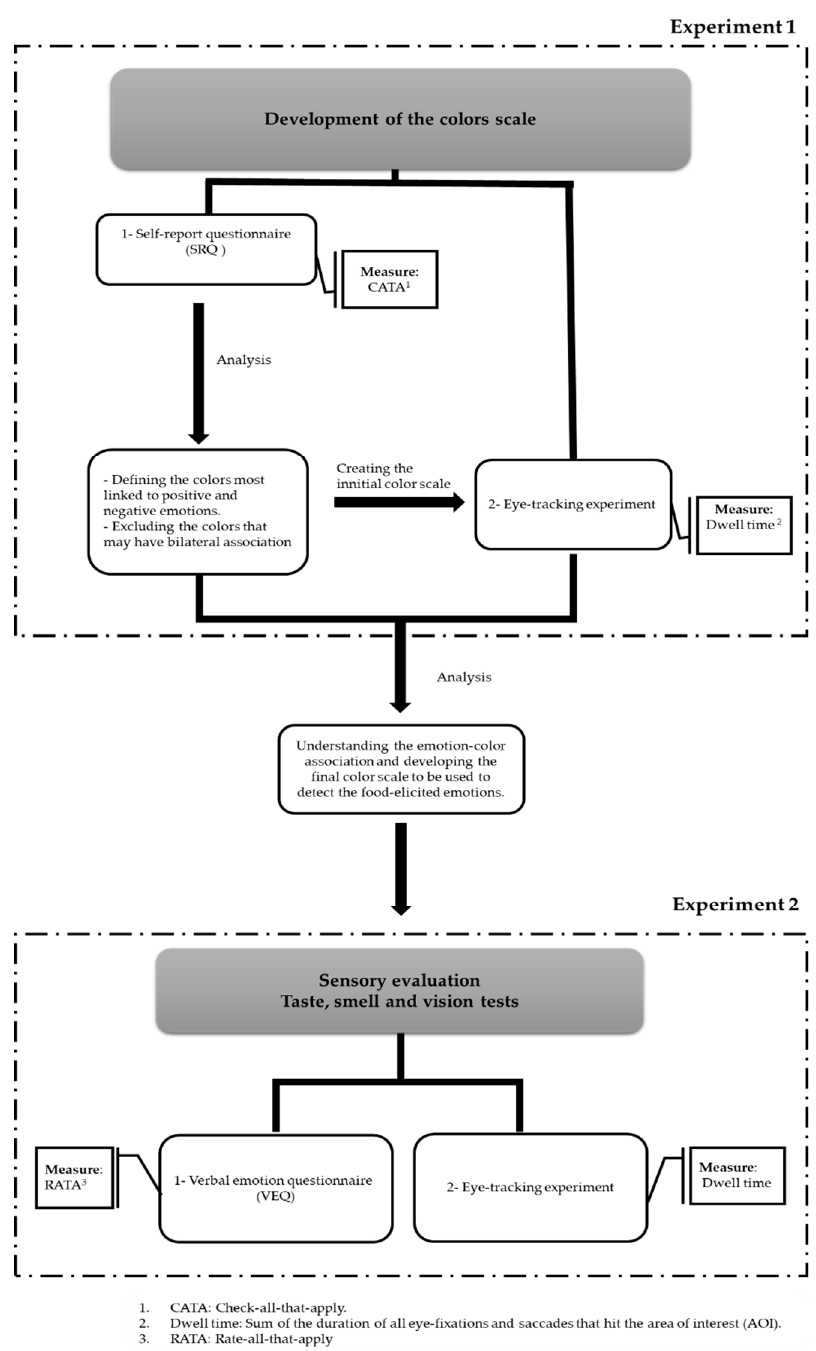
Figure 1. The above flowchart demonstrates the experimental design.